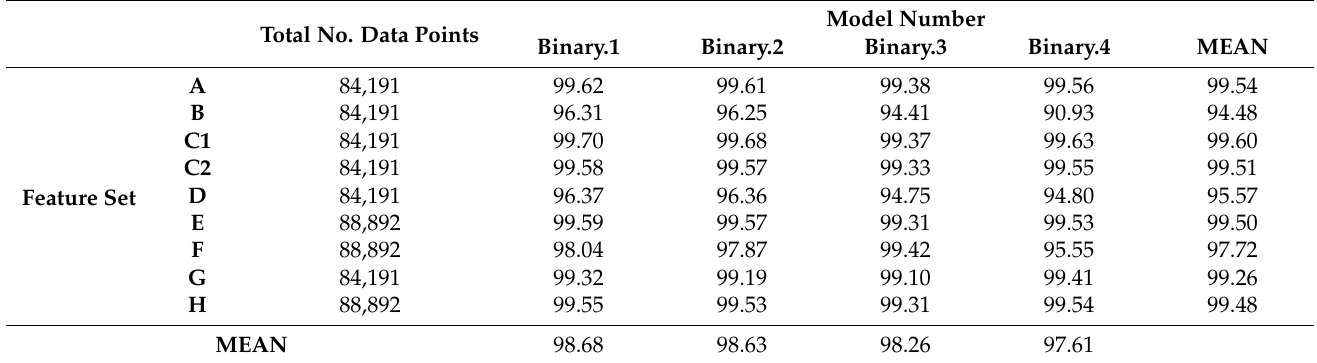
Table 5. A summary of each feature set paired with each model for the binary classification problem, tested using the 70% train, 30% test method. The mean accuracy value for each feature set and model number are also shown.